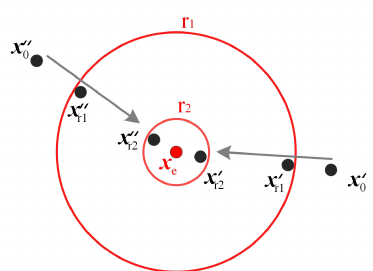
Figure 4. Relationship between the equilibrium states and the convergence